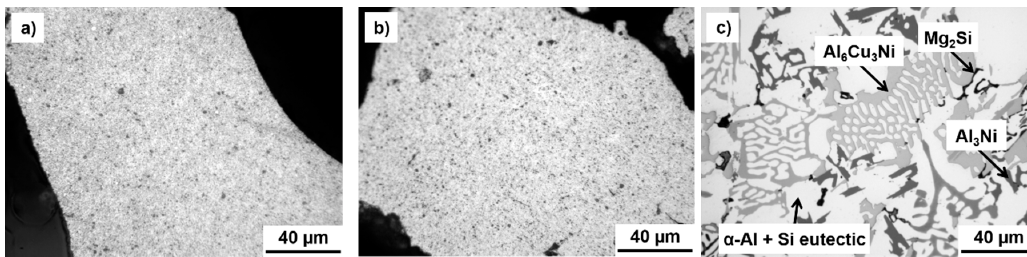
Figure 1. LM (light microscope) of the short-term MA (mechanical alloying): ( a ) Al-20Si-10Fe-6Cr; ( b ) Al-20Si-10Fe-6Mn powder alloys and ( c ) of the as-cast reference Al-12Si-1Cu-1Mg-1Ni alloy.